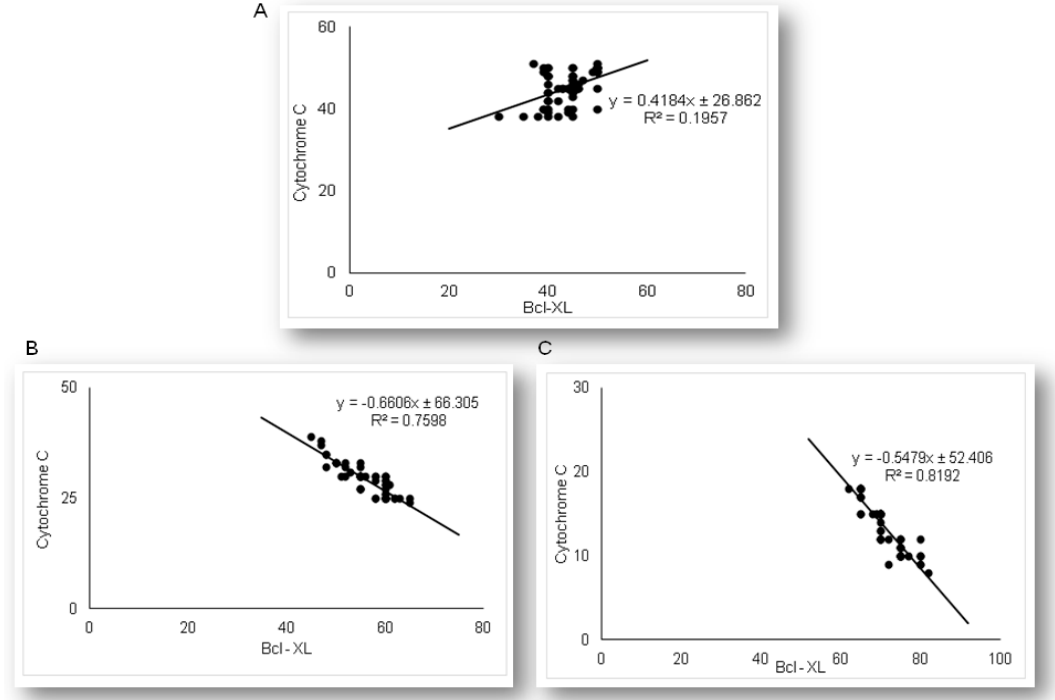
Figure 7. The correlations are shown for Bcl-XL and cytochrome C in the renal tubular epithelial cells: ( A ) LPS group only, ( B ) simvastatin 20 mg/kg group, ( C ) simvastatin 40 mg/kg group. 2.5. Simvastatin Enhanced Survivin Expression in Renal Tubular Epithelial Cells after LPS Administration